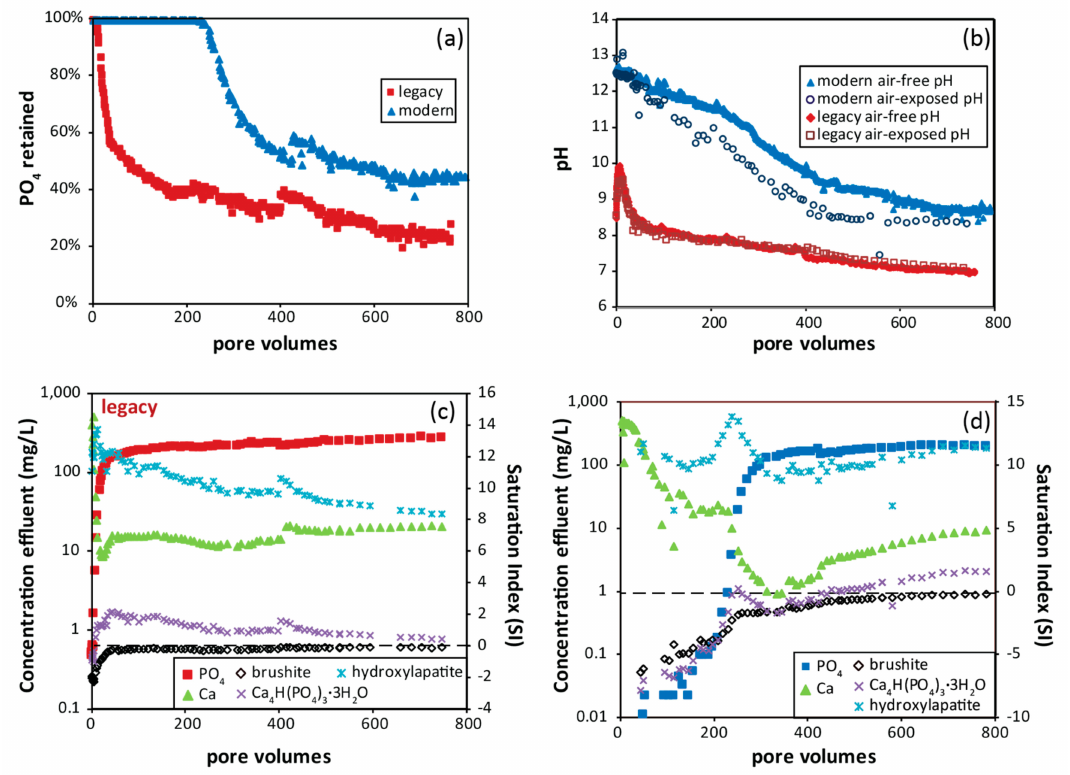
Figure 3. Results from column experiments using modern slag (AMFeC) and legacy slag (ILSS5) from the Chicago-Gary area, Illinois and Indiana. ( a ) Percent phosphate (PO 4 ) retained versus pore volume. ( b ) Air-free pH and air-exposed pH of the e ffl uent versus pore volume. Phosphate and calcium (Ca) concentrations in e ffl uent and saturation indices for Ca-phosphate phases for legacy slag ( c ) and the modern slag ( d ). Horizontal dashed lines mark saturation indices of